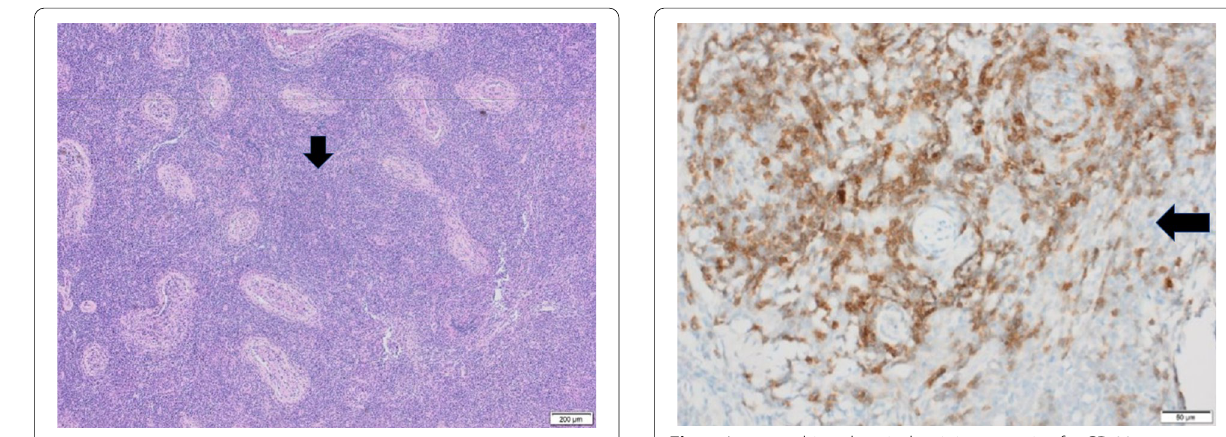
Fig. 3 Diffuse infiltration of right testicular tissue with lymphoid tissue with no obvious nodular architecture